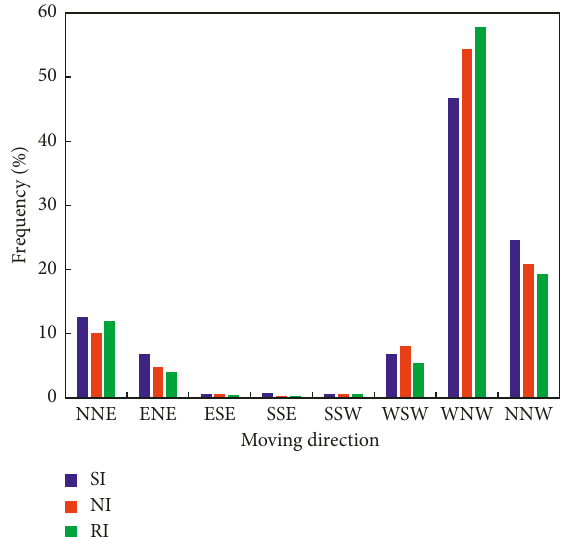
Figure 4: The frequency distribution of the moving direction for the three intensification categories (RI, NI, and SI).